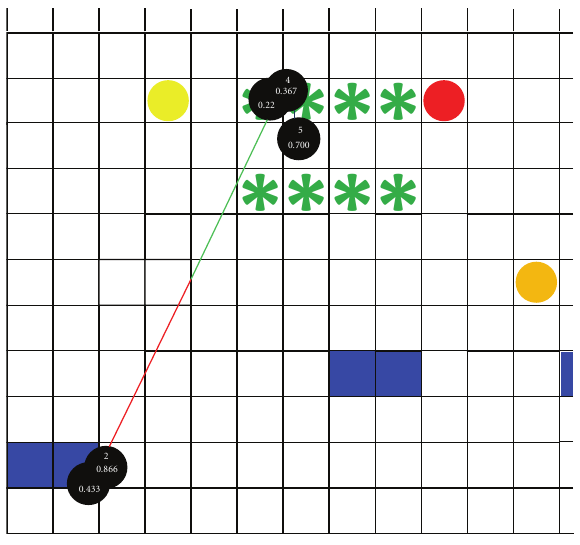
Figure 11: Fixations overlaid on part of